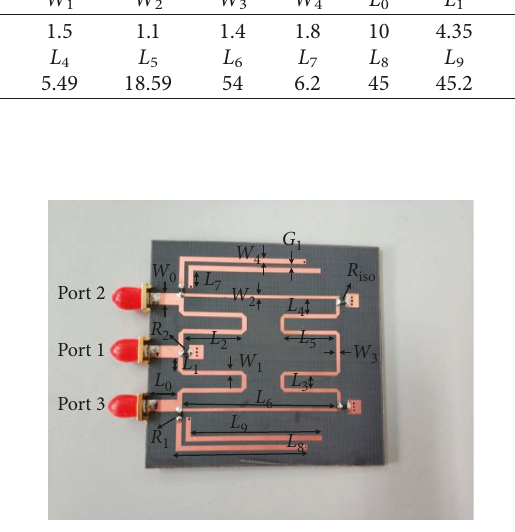
Figure 6: Photograph of the fabricated NGD Gysel power